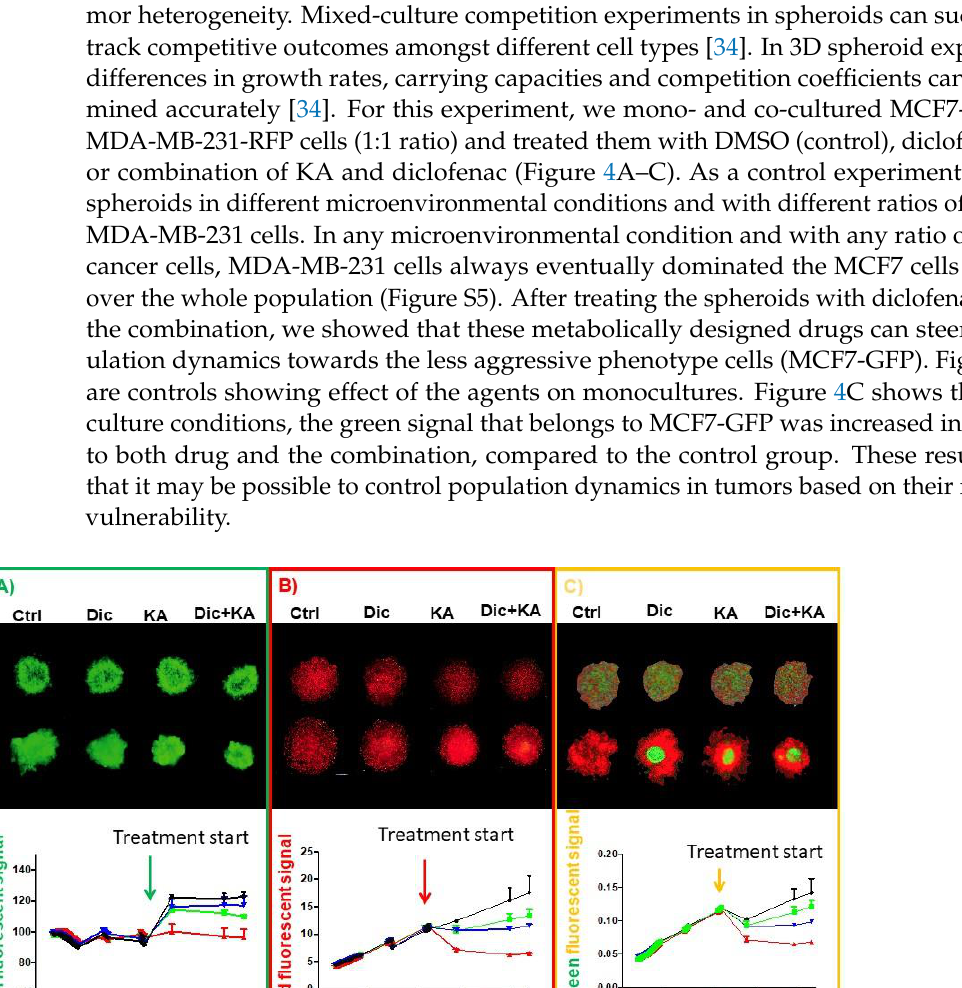
Figure 5. Animal experiments confirm the efficiency of evolutionary designed therapy . ( A ) Female NSG mice injected with a mixture of 5 million MCF7 and 5 million MDA-MB-231 breast cancer cells and randomized into four groups of 6 and treated with, DMSO, diclofenac, KA, and combination. Tumor size is measured every two or three days by calipers and